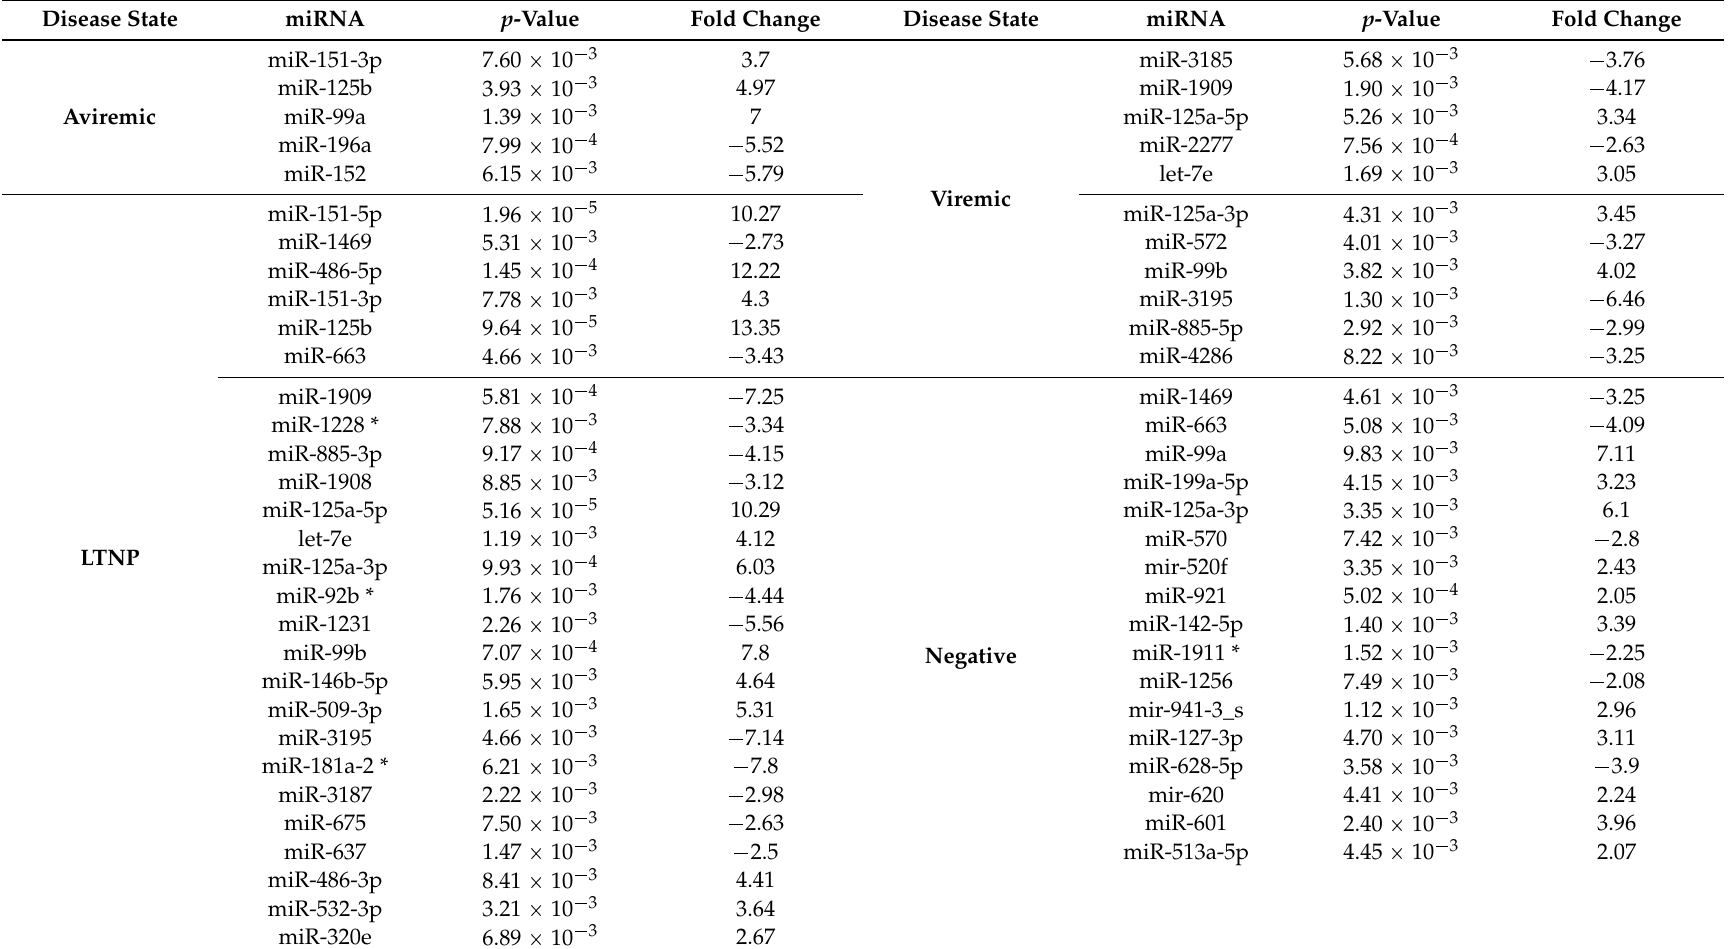
Table 8. DE miRNAs found (using the non-FDR method) by comparing CD4+ with CD8+ T-cells for each disease group. Disease State miRNA